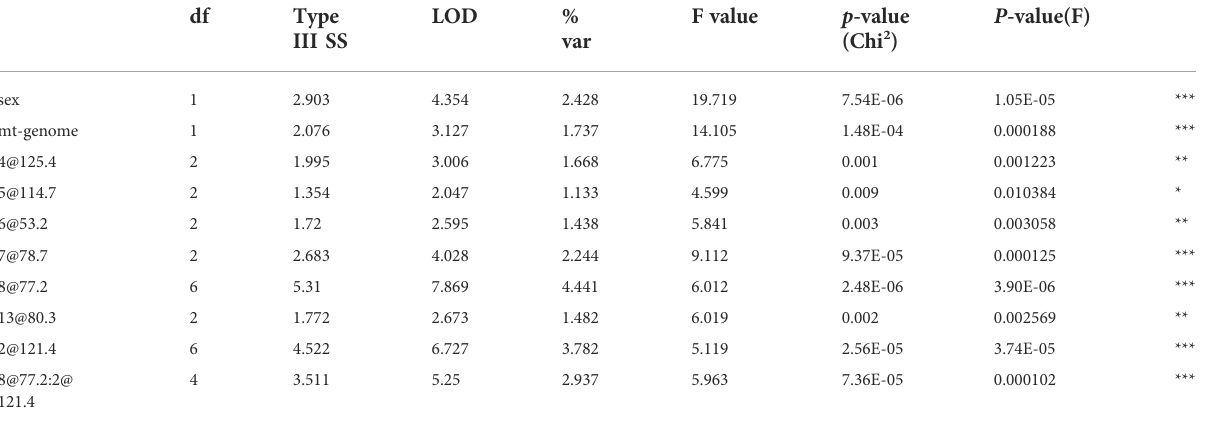
TABLE 3 Multiple regression model, drop one QTL at a time ANOVA